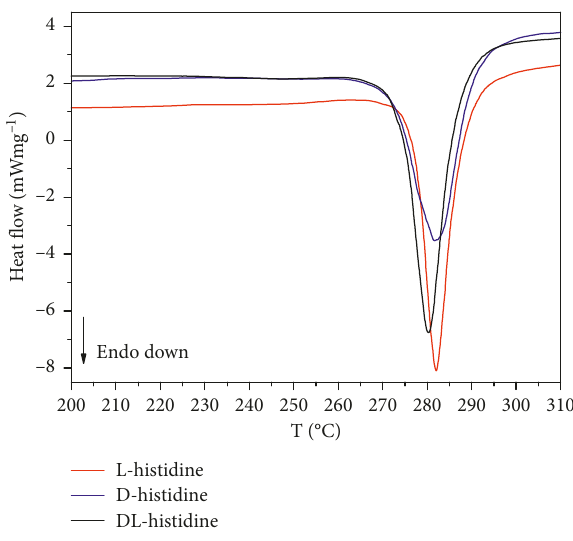
Figure 1: DSC curves for L-, D-, and DL-histidines (10 ° Cmin − 1 ). Table 3: DSC data of isomeric histidines (10 ° C min − 1